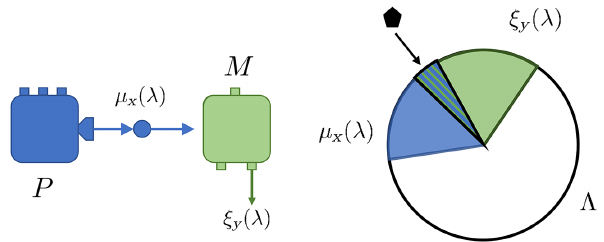
FIG. 1. A prepare-and-measure scenario in an ontological model (left) is modeled by the ontic state space (cid:4) (right). Note that P denotes a preparation represented by an epistemic state (λ) and M denotes a measurement by a response function μ x (λ) . The probabilities extracted from the theory are given by ξ y integrals over the overlap marked by a black pentagon [see Eq.